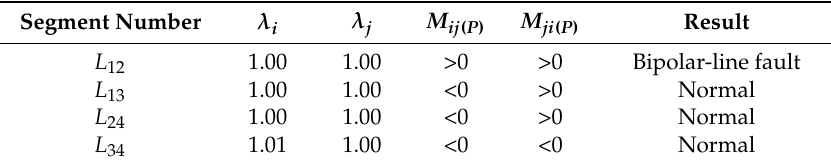
Table 4. Location results of bipolar